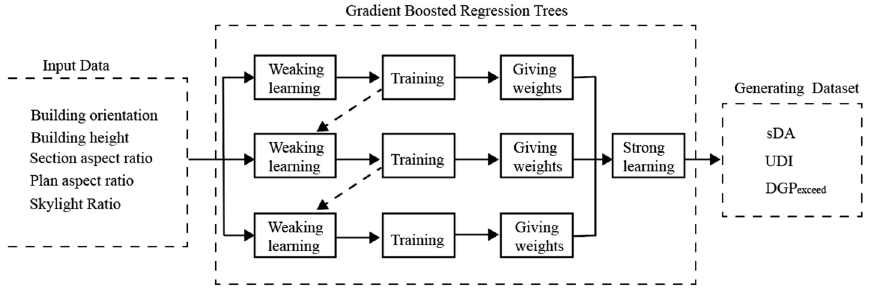
Figure 8. Workflow of GBRT model.